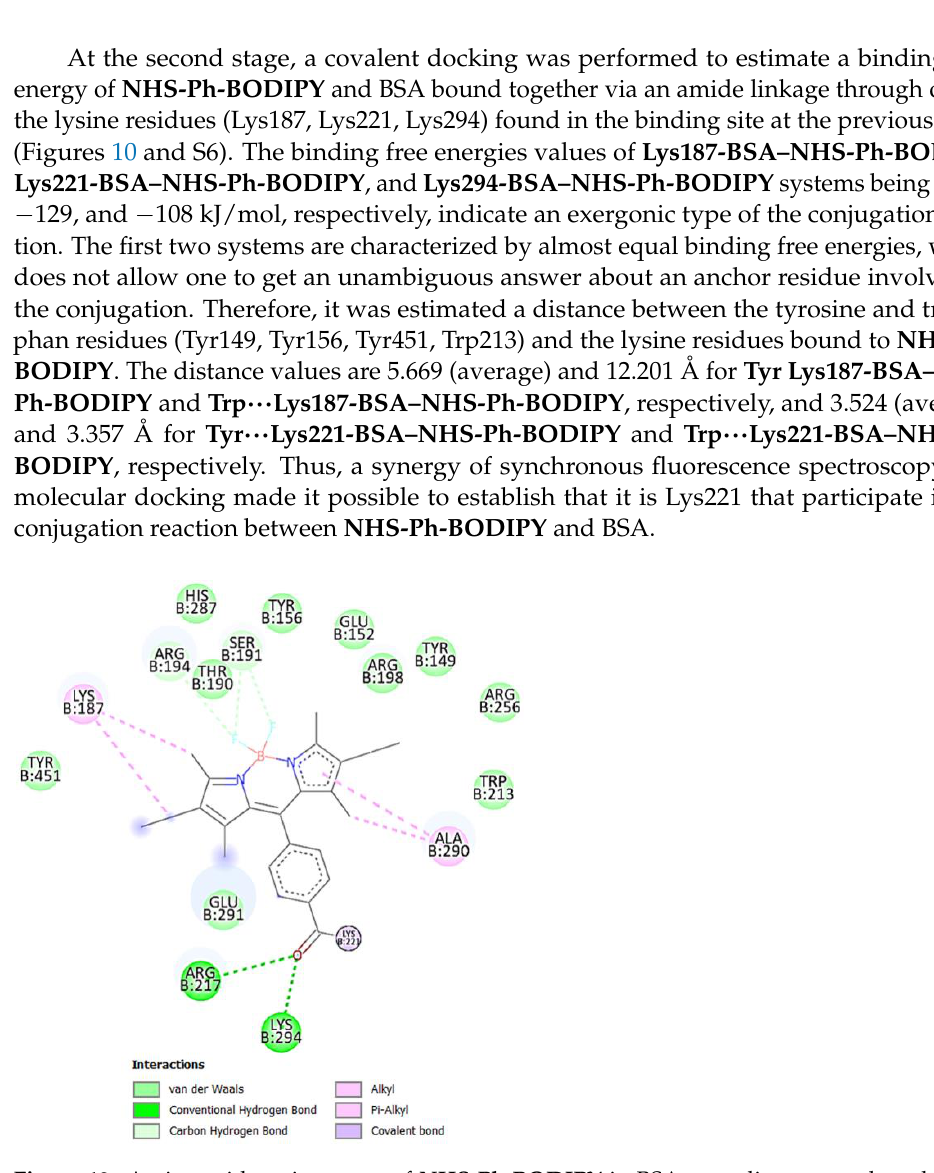
Figure 10. Amino acid environment of NHS-Ph-BODIPY in BSA according to covalent docking results of the Lys221-BSA – NHS-Ph-BODIPY system.